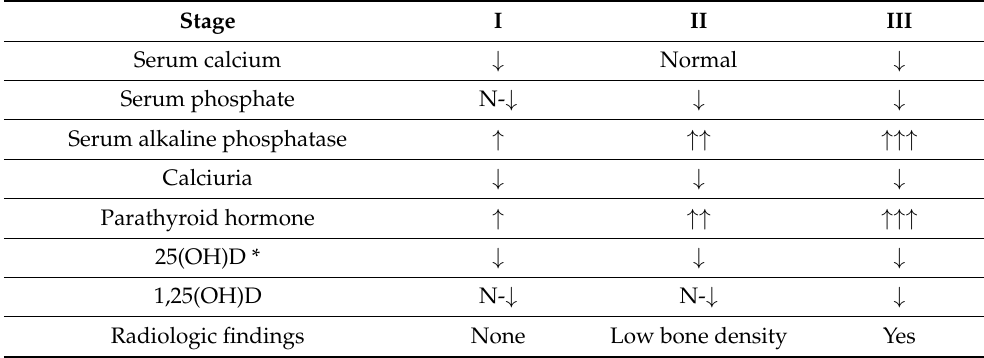
Table 2. Stages of severity in vitamin D deficiency rickets.